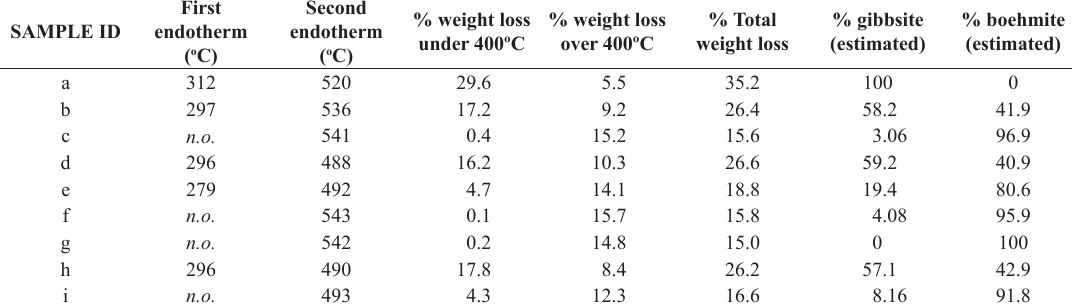
Table 2 – Temperatures of endotherms (from DTA), weight loss percentages (from TGA) and estimates of percentages of gibbsite and boehmite (from TGA